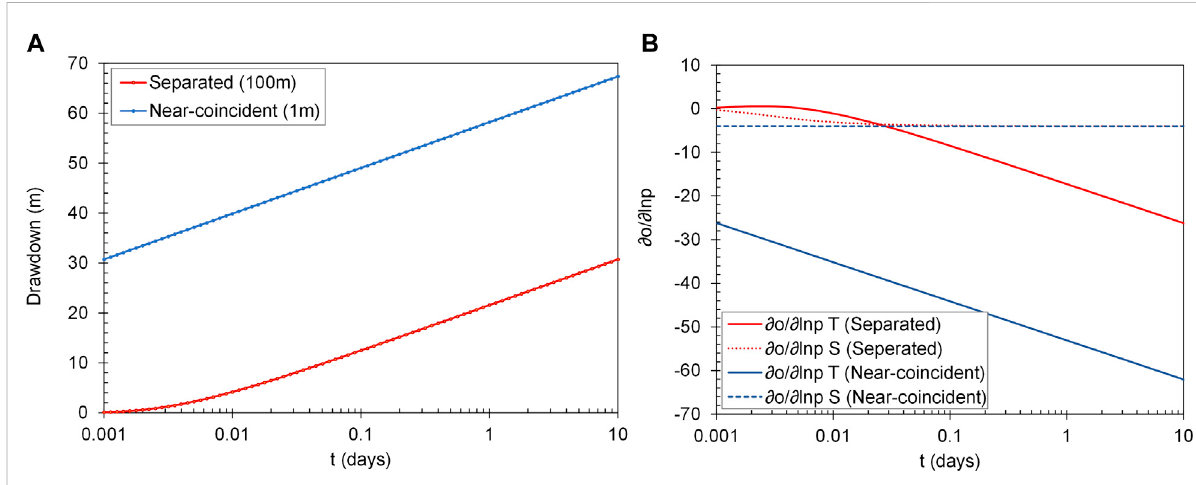
FIGURE 2 (A) Drawdown in the observation well. (B) The derivative of drawdown with respect to the natural logs of global T and S